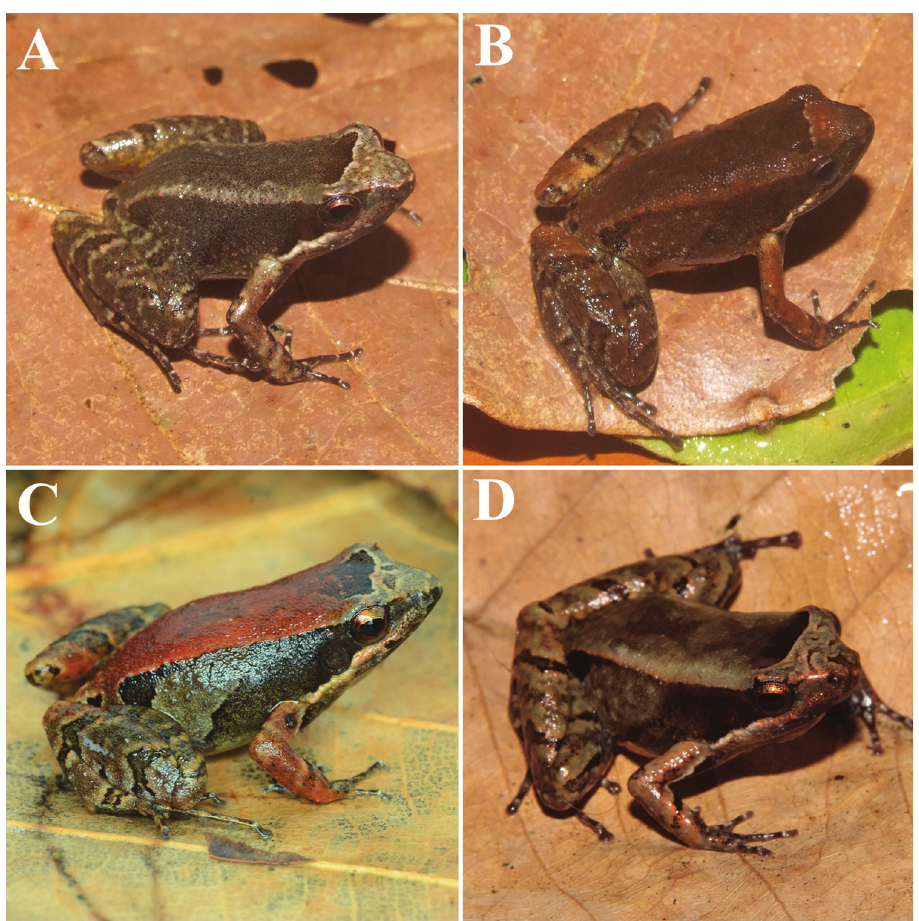
Figure 1. Different individuals of Eleutherodactylus bilineatus showing some variation of the dorsal pat- tern of the species. A and B RPPN Mata do Passarinho, Macarani C Estação Ecológica Wenceslau Gui- marães and D Serra do Corcovado, Almadina, Bahia, Brazil (photographs A, B and D Iuri R. Dias, C Rafael O.